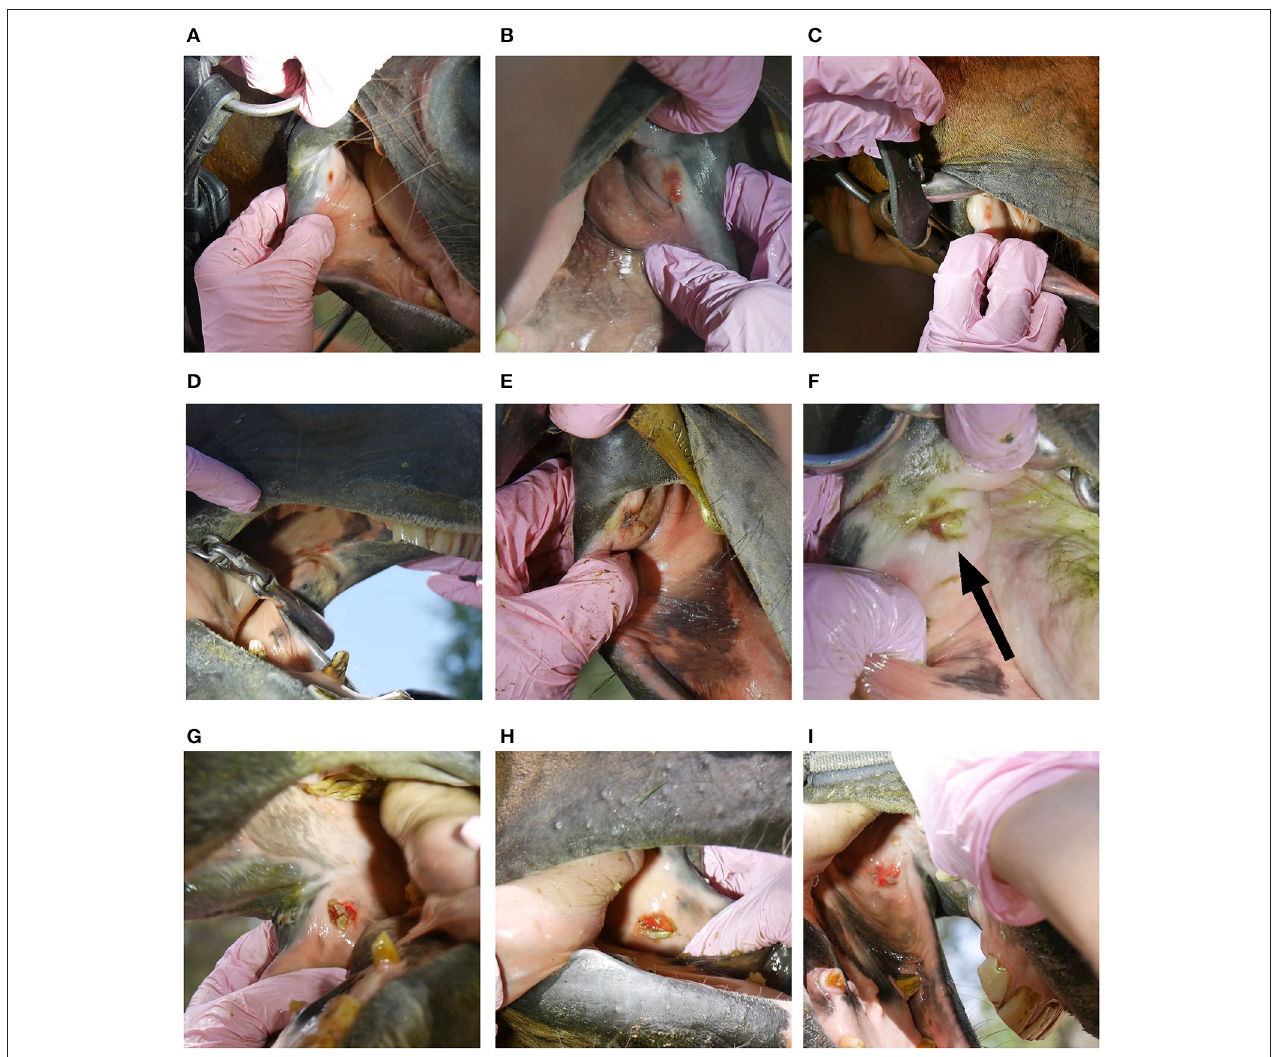
FIGURE 1 | Bit-related inner lip commissure lesions; (A) bruise 2 points (B) bruise 2 points (C) bruise 2 points (D) bruise 3 points (E) wound 4 points (F) wound 6 points (G) wound 6 points (H) wound 6 points (I) wound 6